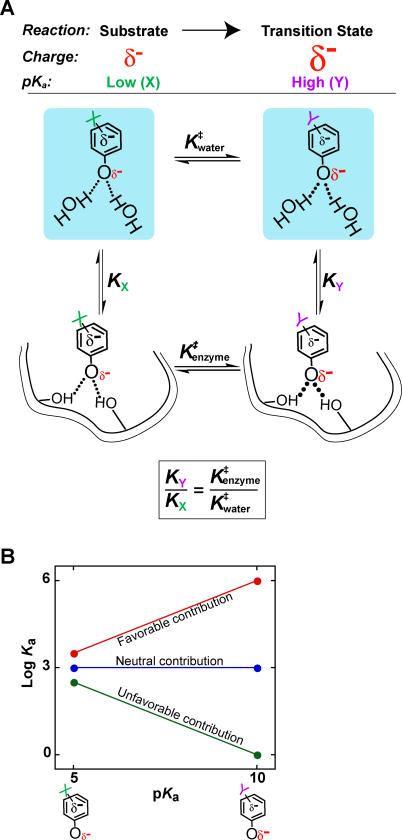
Schematic Depiction of an Experimental Method to Isolate and Probe the Role of Electrostatic Complementarity to the Transition State(A) In the reaction to be probed there is an accumulation of negative charge in the transition state. Two phenolates with different substituents (X and Y) and therefore different p
K
a values and different charge densities on the oxygen atom are used to mimic the increase in charge localization going from the ground state to the transition state. As charge localization on the oxygen increases, hydrogen bonds may strengthen in both water and in the enzyme active site (larger dots for hydrogen bonds formed by phenolate Y). The equilibria and represent the exchange of one phenolate for the other in water and on the enzyme, respectively, mimicking the change in charge localization along the reaction coordinate. The equilibria
K
X and
K
Y are the affinities of the two phenolates, i.e., the equilibrium for their transfer from water to the enzyme.
(B) The log of the affinities of the substituted phenolates from (A) are plotted versus p
K
a. If the phenolate with substituent Y binds more strongly than that with substituent X (red;
K
Y >
K
X), then the enzyme is better than water at stabilizing increased charge localization and there is a favorable contribution to catalysis from electrostatic complementarity. The sign and steepness of the slope, as established using a series of substituted phenolates, can determine the sign and magnitude of the contribution to catalysis.